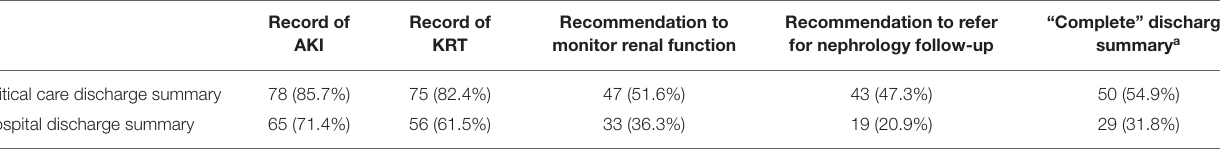
TABLE 2 | Discharge documentation.